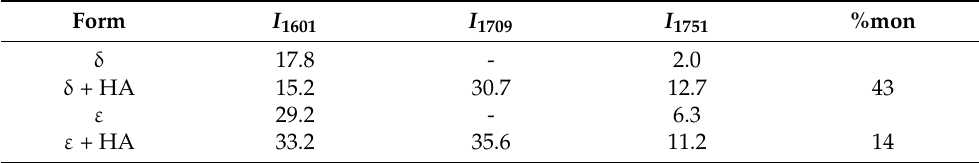
Table 1. Integrated absorbances (in cm − 1 ) obtained by non-linear least square fitting of the spectra as sum of Lorentzian peaks, and the derived percentage of isolated guest HA molecules.